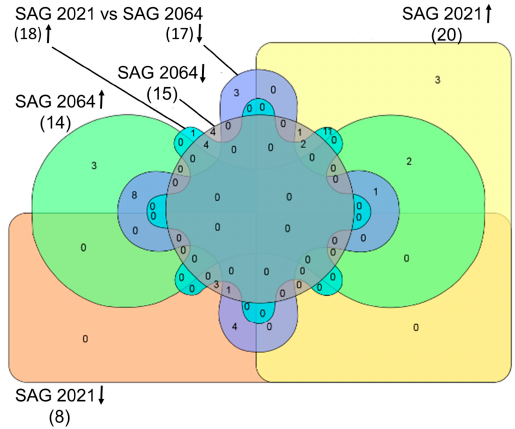
Figure 2. Venn diagram created using InteractiVenn, a web-based tool to compare the accession numbers of proteins identified. Total number of proteins is listed within the parenthesis, up- and down-arrows indicate up- and down-regulated proteins, respectively. Colour codes: yellow-SAG 2021 up-regulated, orange-SAG 2021 down-regulated, green-SAG 2064 up-regulated, purple-SAG 2064 down-regulated, blue-SAG 2021 up-regulated and grey SAG 2064 down-regulated. Among seven differentially expressed proteins, three (V-type H + ATPase, fructose-bisphosphate aldolase and an uncharacterized protein) and four proteins (a member of heat shock protein 70, citrate synthase, acetyl-coenzyme A synthetase and uncharacterized protein) were respectively upregulated and down-regulated in both SAG 2021 and SAG 2064. Among these proteins, fructose-bisphosphate aldolase and a member of heat shock protein 70 appeared to be upregulated in SAG 2021 when compared to SAG 2063.